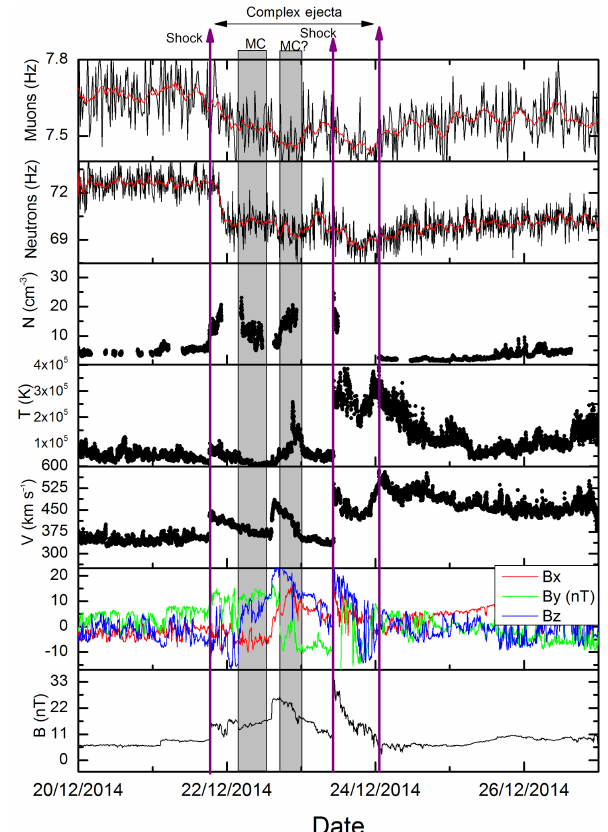
Figure 16. From top to bottom, muon count rate (black line) and smoothed count rate (red line), neutron count rate (black line) and smoothed count rate (red line), solar wind density, solar wind temperature, solar wind speed, interplanetary magnetic field com- ponents and magnetic field intensity. “Complex ejecta” refers to a complex solar wind structure composed of different interacting structures like shocks, ICMEs and interaction regions. The vertical purple lines mark the interplanetary shock positions and the ejecta’s